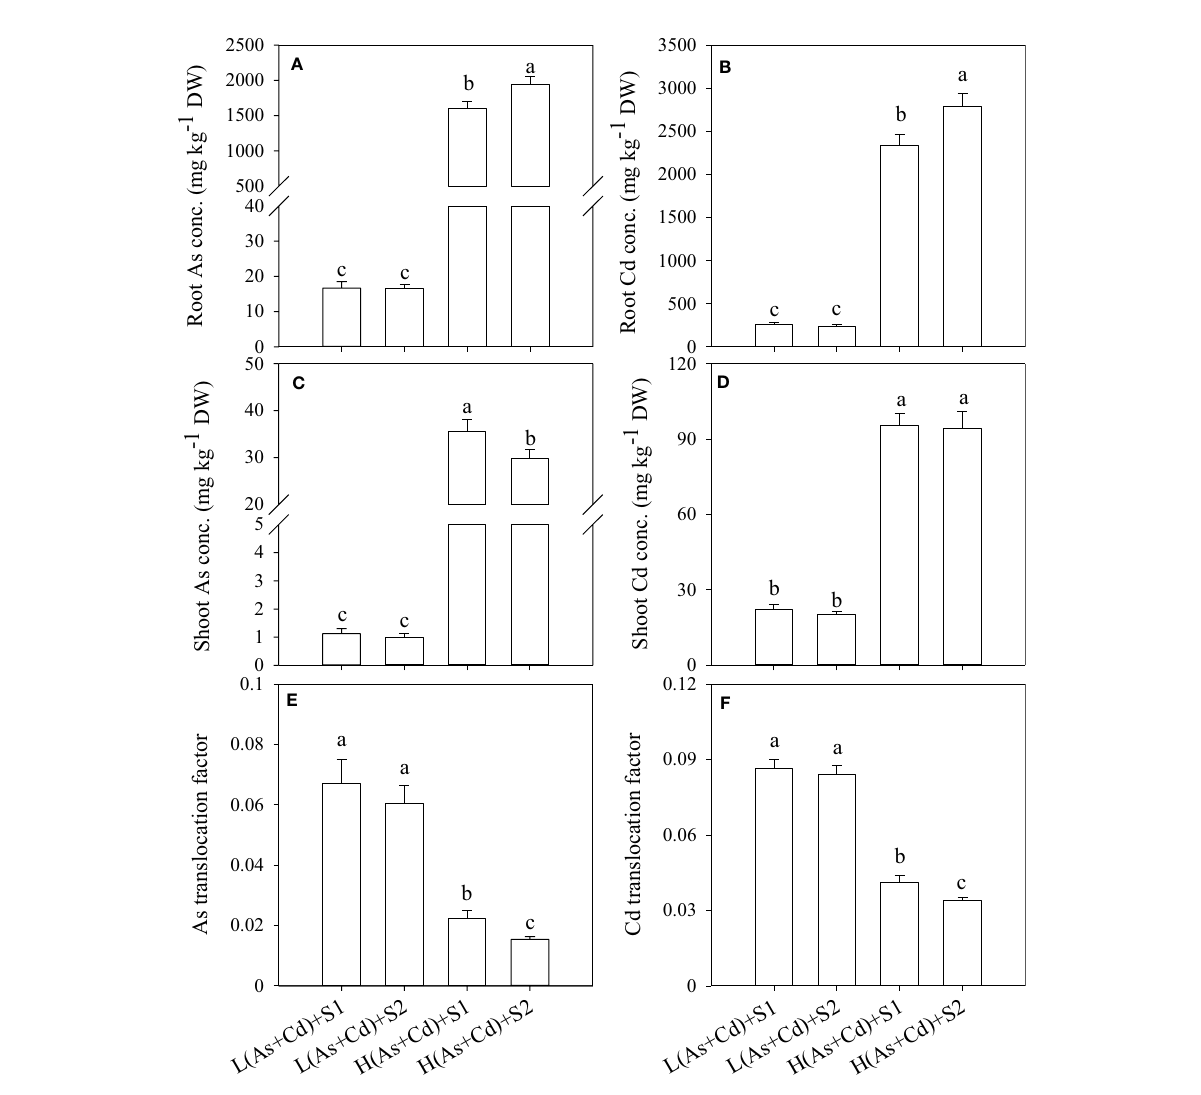
FIGURE 2 Arsenic and Cd accumulation and translocation in wheat plants grown in low S or high S nutrient solution after 6 days of As plus Cd exposure. S1, de fi cient sulfate; S2, suf fi cient sulfate; L(As+Cd), low As plus Cd; H(As+Cd), high As plus Cd. Data are means ± SD ( n = 3). Different letters in the same column indicate signi fi cant differences among treatments at p ≤ 0.05 according to Duncan ’ s multiple comparison